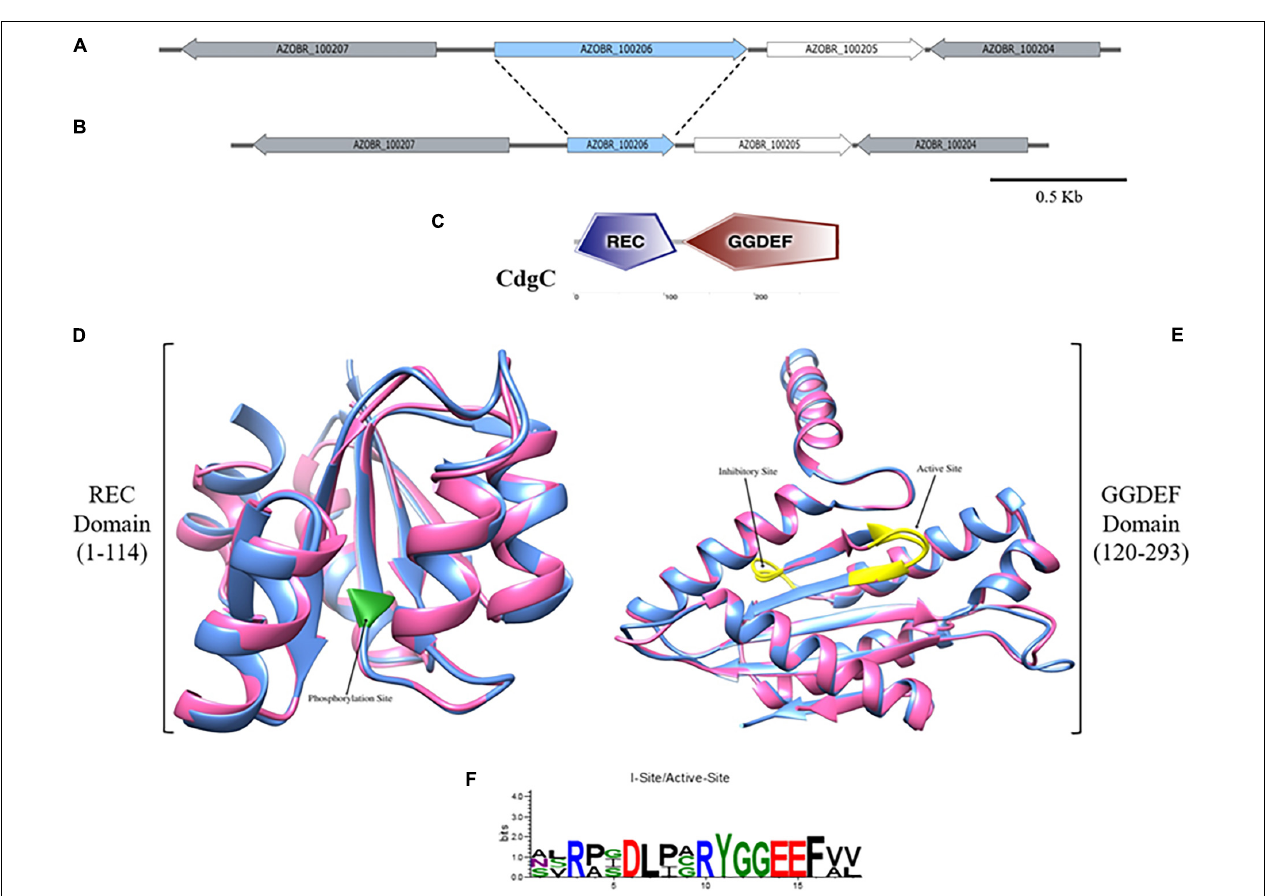
FIGURE 1 | Domain-architecture and structure prediction of CdgC. (A) Genetic context of the AZOBR_100206 (marked in blue) gene which codifies for the CdgC protein. Downstream of it and separated by an intergenic region of 68 pb, AZOBR_100205 gene is found. (B) Scheme representation of the genetic context after the deletion of 509 pb belonging to the ORF of cdgC gene. This deletion leaded to the loss of the nucleotides that encode for the catalytic and inhibitory sites of the GGDEF, and the aspartate 51 located at the REC domain. Bar represents 500 pb. (C) Graphic representation of the domain architecture of CdgC obtained from the webserver SMART. (D) Superimposed ribbon diagrams from the REC domain of CdgC (pink) and the REC domain of WspR (blue) from P. aeruginosa . The residue involved in phosphorylation is marked in green. (E) Superimposed ribbon diagrams from the DGC domain of CdgC (pink) and the DGC domain of WspR (blue) from P. aeruginosa . Active and inhibitory sites are colored in yellow. Modeling of the REC and DGC domains of CdgC was carried out employing WspR as a model. REC domain (C-score: 1.38; TM-score: 0.91 ± 0.06; RMSD: 1.7 ± 1.4 Å), DGC domain (C-score: 1.71; TM-score: 0.95 ± 0.05; RMSD: 1.8 ± 1.5 Å). (F) Web Logo showing conserved inhibitory and active sites of CdgC compared to